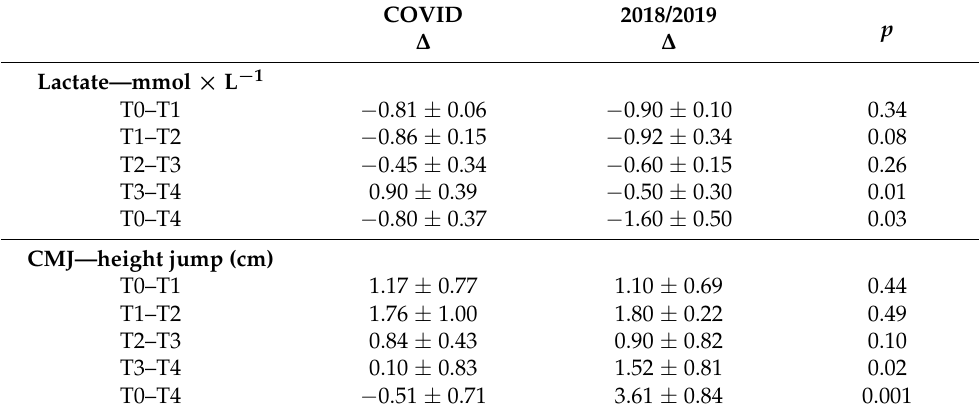
Table 7. Differences ( ∆ ) in blood lactate concentrations and CMJ between each timepoint in football players all for 2018/2019 and 2019/2020. p -values < 0.05 obtained by t -test show statistical differences in ∆